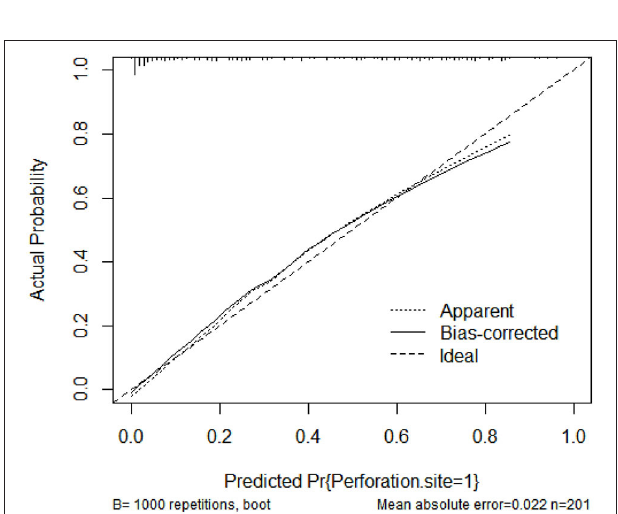
FIGURE 3 | Calibration curves of the nomogram model showing the predicted vs. actual probability for upper GIP (gastrointestinal perforation) in the training cohort.